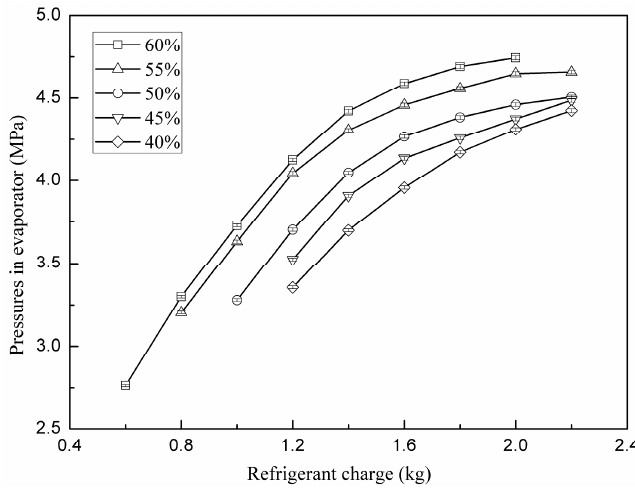
Figure 7. Variations of the pressures in evaporator with refrigerant charge and EEV opening.